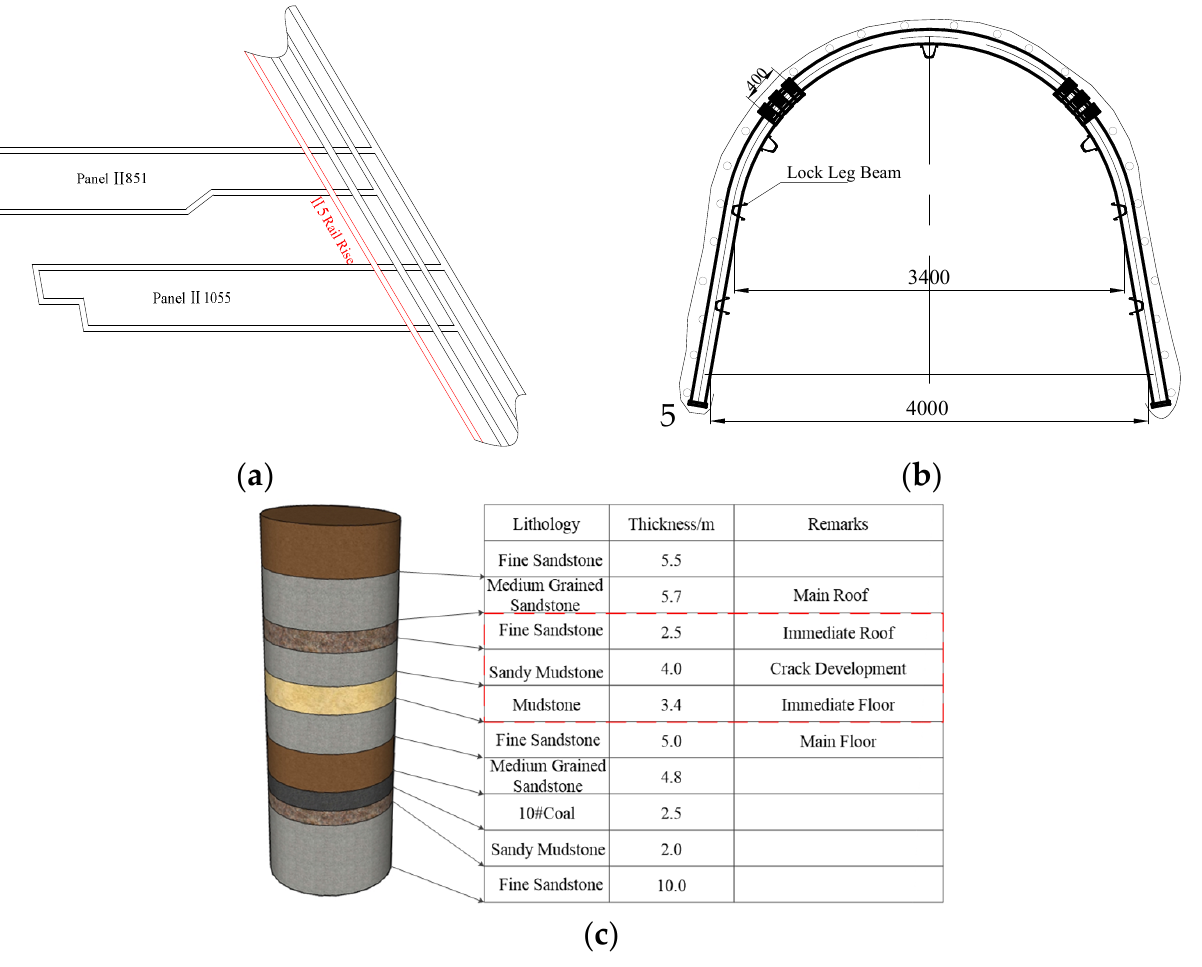
Figure 1. Basic information of the roadway. ( a ) Layout plan of the II5 Rail Rise; ( b ) Initial support of the roadway; ( c ) Geological histogram.